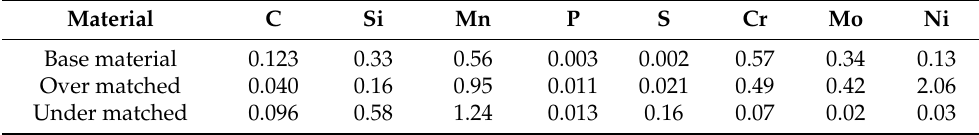
Table 3. Actual chemical composition (in weight %).